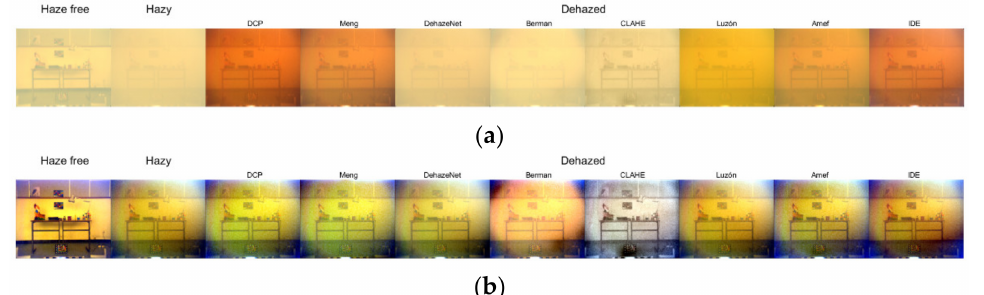
Figure 4. From left to right: Original haze-free image, image with haze and restored images. ( a ) sRGB rendering using the information contained in the 450–720 nm spectral range with a medium haze level (SHIA level 7 [64]); ( a ) images in ( b ) with contrast stretching applied (only for visualization